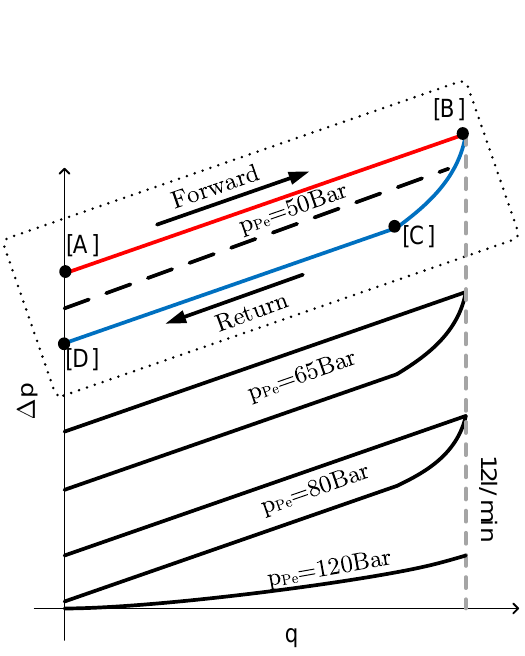
Figure 12: Sketch of typical CBV data.